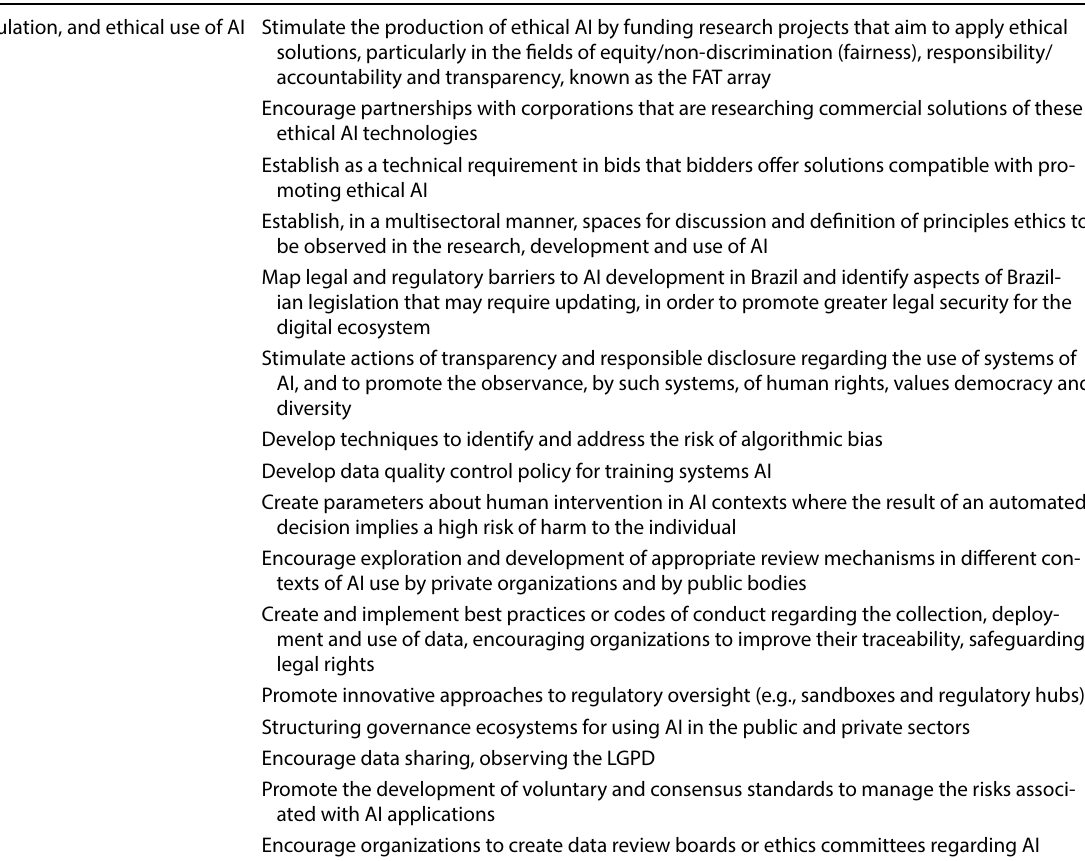
Table 1 Strategic actions by EBIA